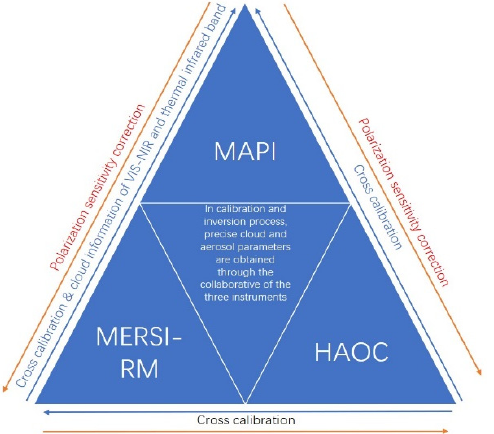
Figure 9. Schematic diagram of collaborative observation of MAPI, MERSI-RM and HAOC.